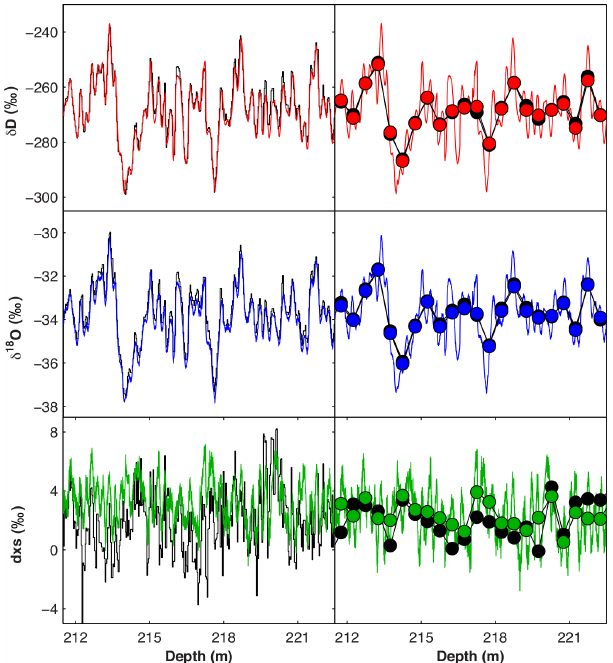
Figure 9. Data from the WDC over a depth range of ∼ 212–222m. In the left column, high-resolution CRDS-CFA data for δ D (red line), δ 18 O (blue line), and dxs (green line) are compared with traditional high-resolution IRMS discrete samples (black lines). In the right column, comparison of high-resolution CRDS-CFA data (red, blue, and green lines), low-resolution University of Washing- ton CRDS discrete samples (black dots), and down-sampled CRDS- CFA data (red, blue, and green